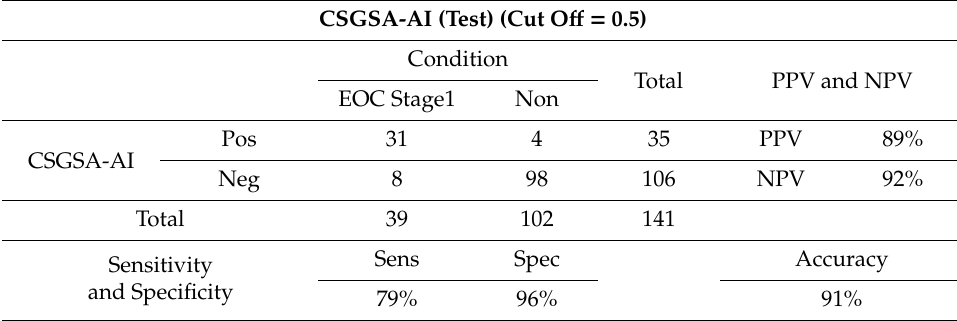
Table 2. Sensitivity and specificity of CSGSA-AI.